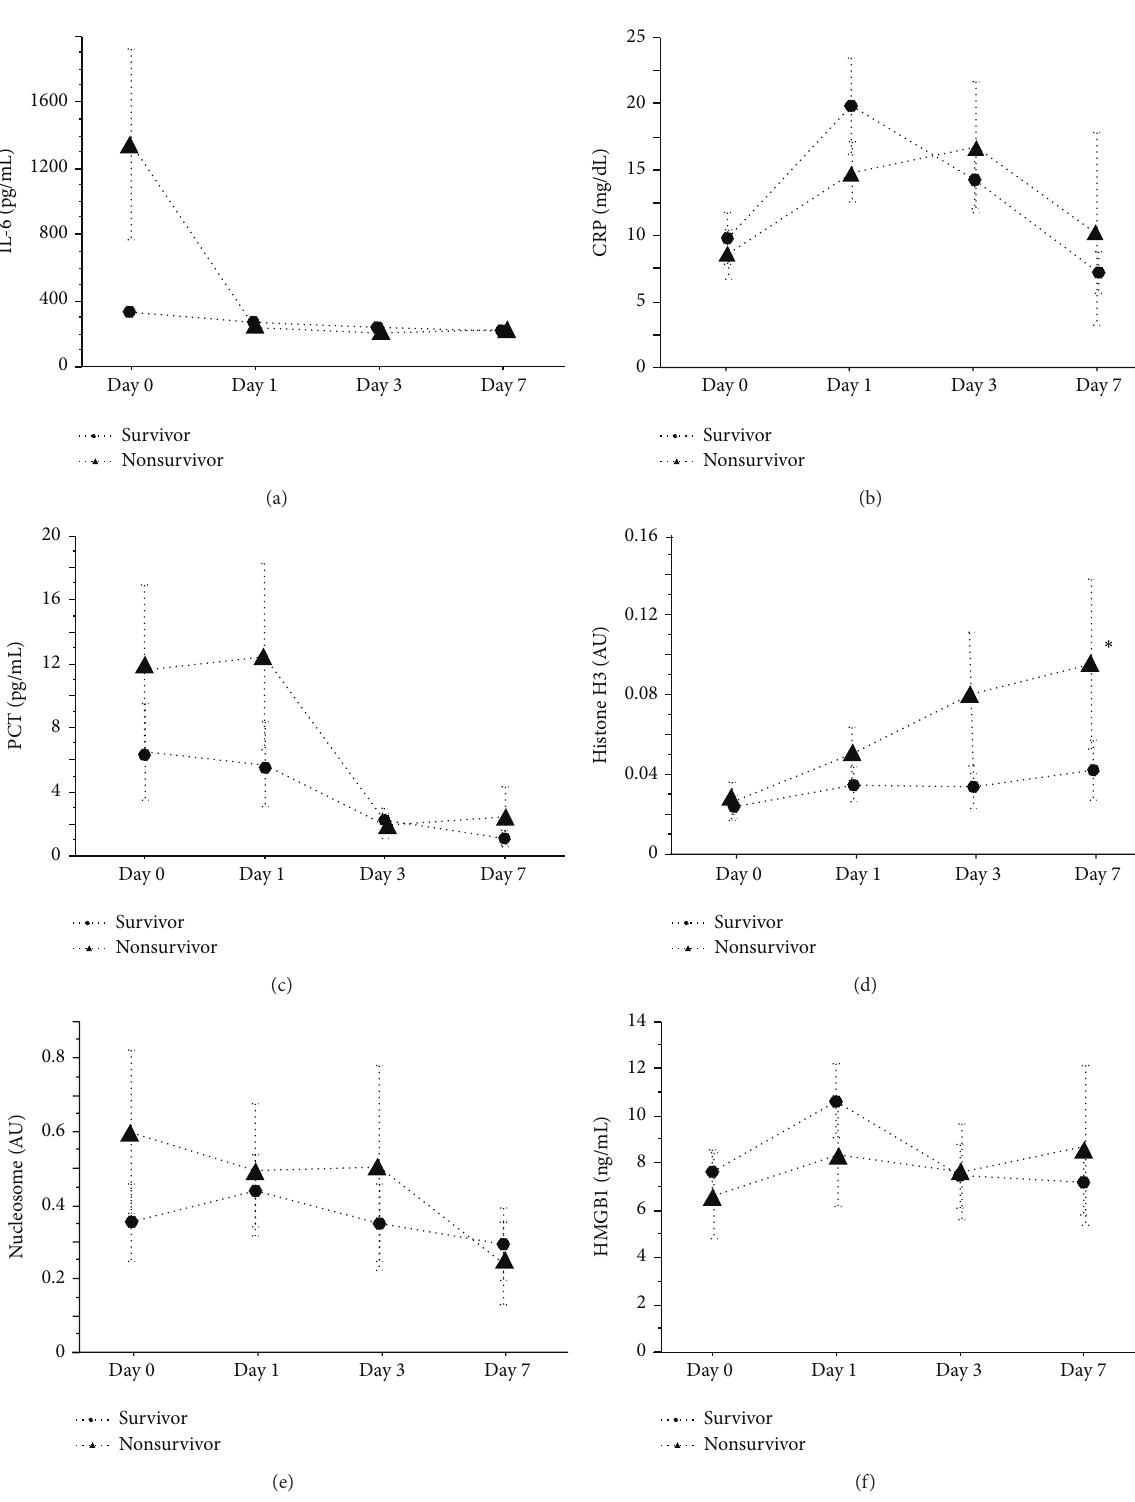
Figure 3: Comparisons of biomarkers between survivors group and nonsurvivors group. The time-courses of various biomarkers in survivors group and nonsurvivors group are plotted ((a) IL-6, (b) CRP, (c) PCT, (d) histone H3, (e) nucleosome, and (f) HMGB1). No difference was observed between the two groups in IL-6, CRP, PCT, nucleosome, and HMGB1, while histone H3 level was higher in nonsurvivors group on Day 7. Data are expressed as means ± standard error. AU: absorbance units, IL-6: interleukin 6, CRP: c-reacting protein, PCT: procalcitonin, and HMGB1: high-mobility group protein Box 1, ∗ 𝑝 < 0.05